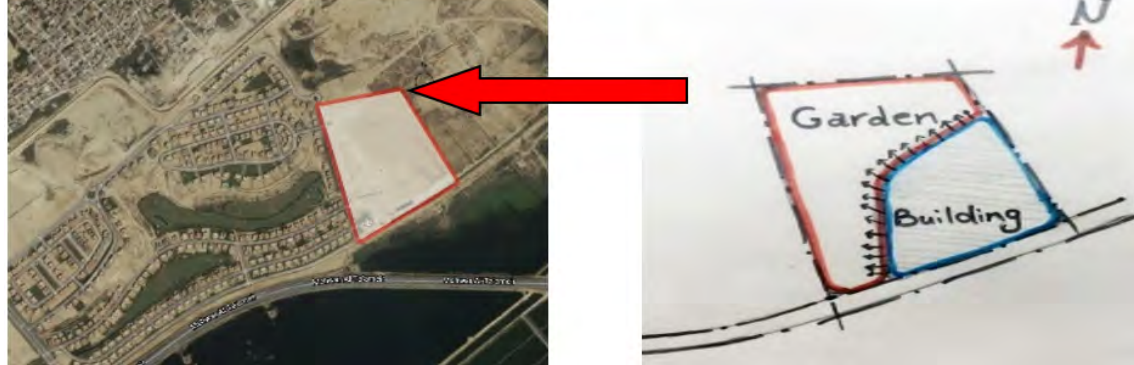
Figure 4. Site plan for the chosen